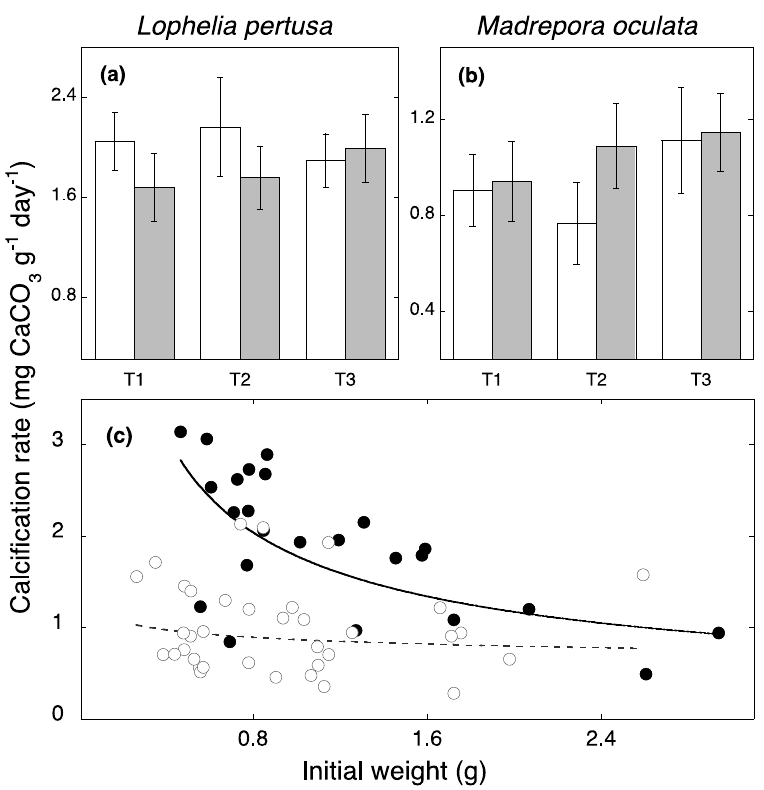
Figure 1. Skeletal growth rates of ( a ) Lophelia pertusa ; and ( b ) Madrepora oculata under ~8.10 units) and acidified conditions (grey bars; pH ~7.81 units) control (white bars; pH T T taking as a reference the weight at the beginning of each sampling period (T1, T2 and T3 represents 62, 118 and 182 days, respectively; results expressed as mean ± SE; N = 12 in L. pertusa and 18 in M. oculata ); ( c ) Correlation between the initial weight of the nubbins and their calcification rate at the end of the experiment computed for the whole duration of the experiment (182 days), for L. pertusa (solid line, black dots) and M. oculata (dashed line, white